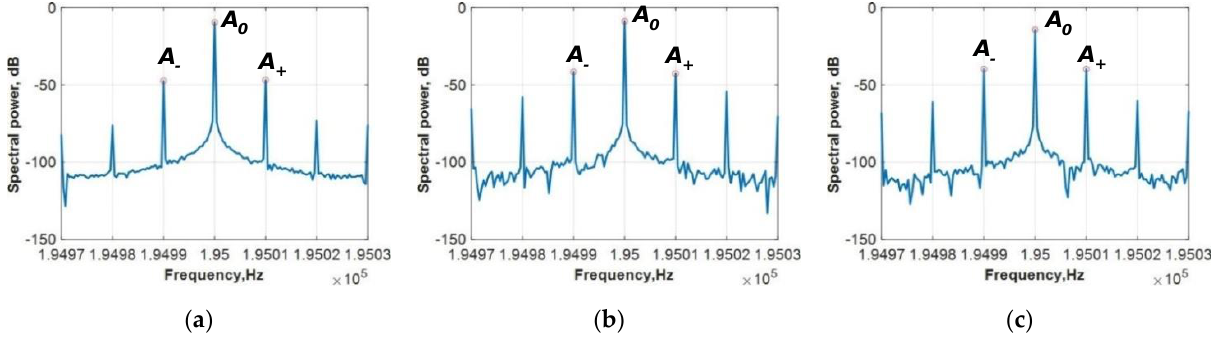
Figure 6. Spectra in the frequency window of 60 Hz around the probe frequency f = 195 kHz for Sample #5: ( a ) after 0 normalized cycles, no visible crack; ( b ) after 0.69 normalized cycles, initial damage accumulation; ( c ) after 0.9 normalized cycles, visible crack.